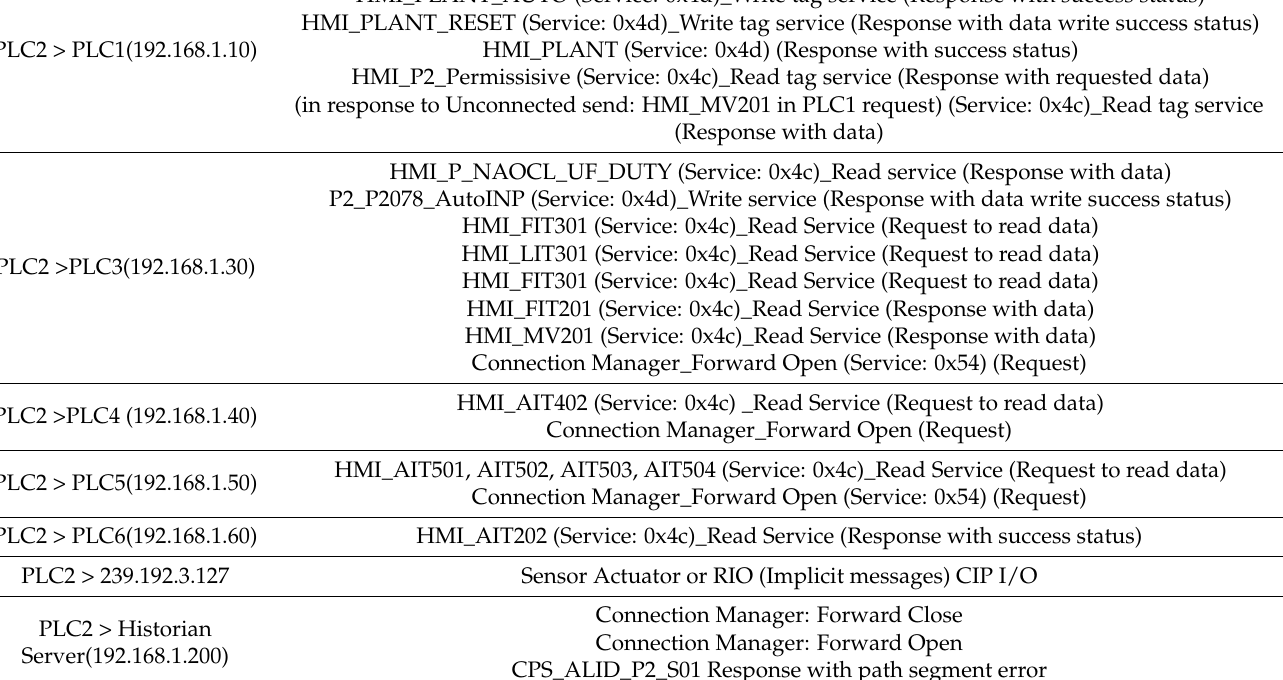
Table A3. PLC3 Communications in